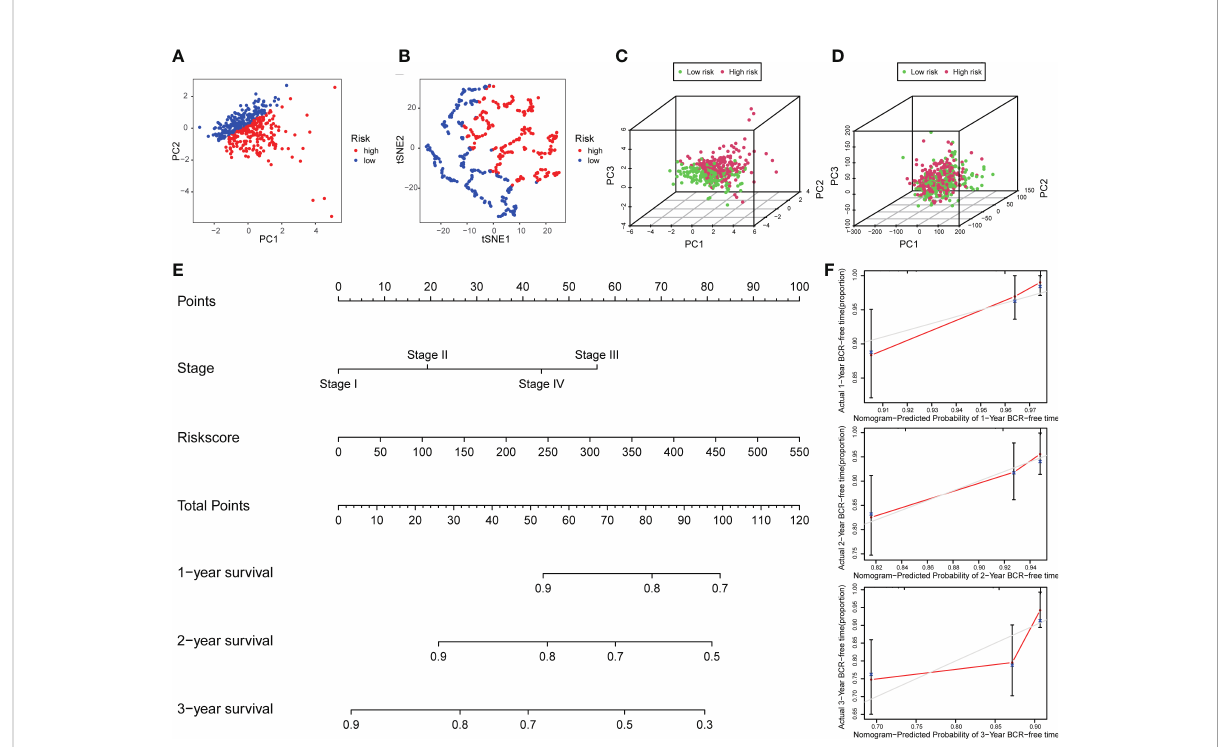
FIGURE 6 Distribution analysis and nomogram of the signature. (A) t-SNE and (B) 2D PCA analyses of the signature. 3D PCA analysis based on (C) all CLCs and (D) genome-wide expression pro fi les. (E) Construction of a nomogram predicted the probability of 1-, 2-, and 3- years BCR-free survival of PCa patients. (F) The calibration curves veri fi ed the accuracy of